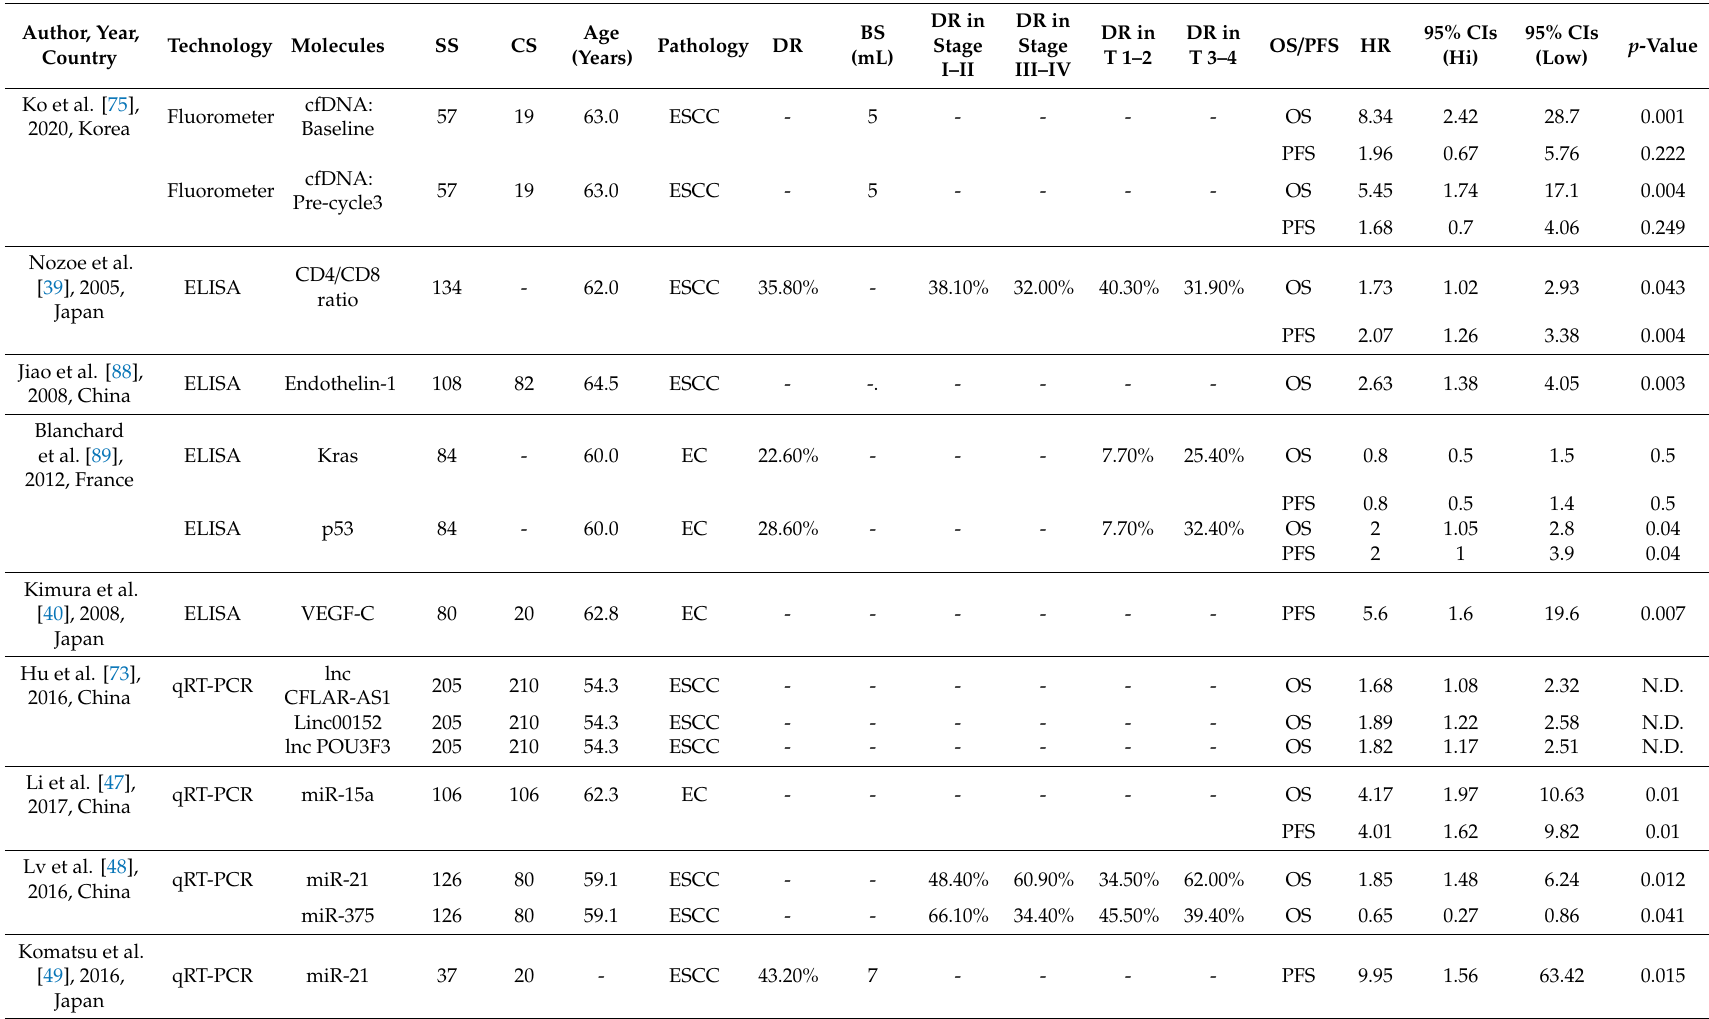
Table 2. The results of liquid biopsies for prognostic evaluation in the non-cytometric